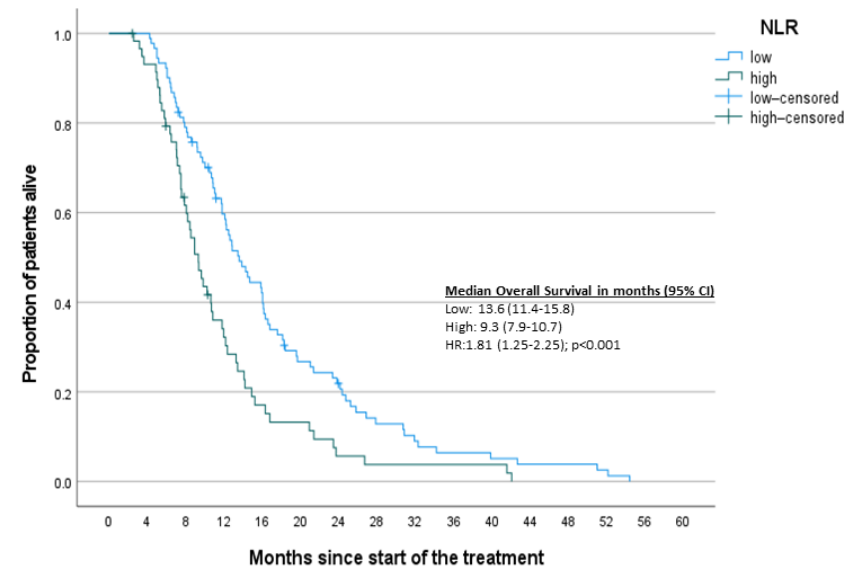
Figure 2. Kaplan–Meier curves for OS-NLR .